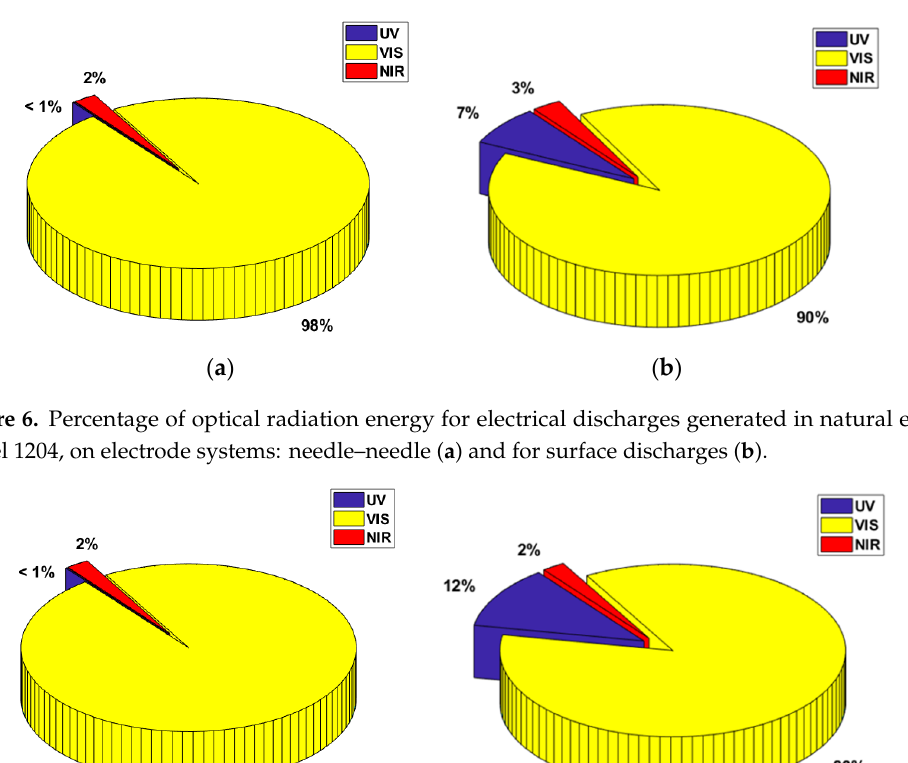
( a ) ( b ) Figure 8. Percentage of optical radiation energy for electrical discharges generated in mineral oil, Orlen Trafo EN, on electrode systems: needle–needle ( a ) and for surface discharges ( b ). This is probably due to various energy transformations accompanying the phenomenon of electrical discharges, which occurs in the used electrode systems. In the electrode system of the needle–needle type, electric discharges mostly occur in the form of a spark, while in the system for surface discharges, the phenomena occur continuously. Radiation in the ultraviolet range, in the case of discharges in the needle–needle system, is short-lived and effectively suppressed. 5. Conclusions The spectral distribution of the optical radiation emitted by electrical discharges in insulating liquids differed according to the electrode geometry. Needle–needle electrodes had < 1% UV radiation in all analyzed cases. In contrast, surface discharges had 7% or more UV radiation, depending on the type of electrical insulating liquid. This result might allow identification of the discharge type from the radiation spectrum and might be incorporated in expert diagnostic systems used in various technical areas. The results also justify further research, in terms of the applicability of the proposed indicator, for recognizing forms of electrical discharges in high-voltage insulation systems. Funding: This research was co-funded by the National Science Centre, Poland (NCN) as a part of the Preludium Research Project No. 2017/25/N/ST8/00590. Conflicts of Interest: The author declares no conflict of interest. The funders had no role in the design of the study; in the collection, analyses, or interpretation of data; in the writing of the manuscript; or in the decision to publish the results.